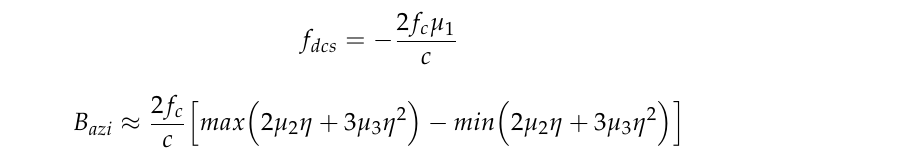
Figure 3. Simulated results for range migration and Doppler frequency migration: ( a ) Range walk migration; ( b ) Range curvature migration; ( c ) Cubic RCM; and ( d ) Doppler centre shift and Doppler bandwidth.